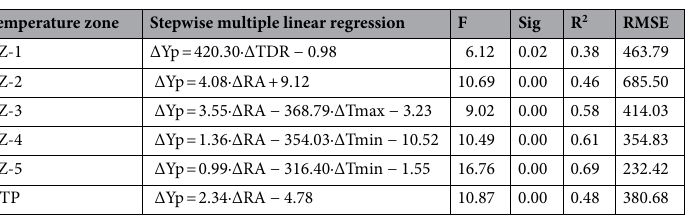
Table 5. Step multiple linear regression results based on HB potential yield and climatic factors in different effective accumulated temperature zones and the whole Qinghai-Tibet Plateau during 1978–2017.